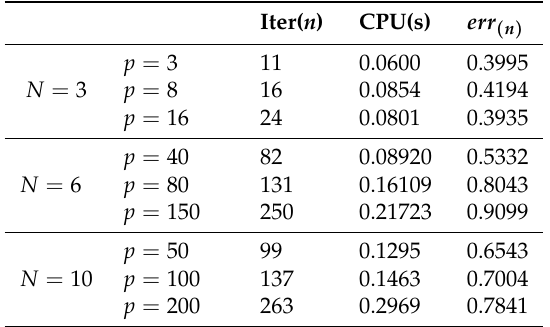
Table 1. Performance of Algorithm 1 for different N and different dimensions p = q with TOL = 10 − 3 .